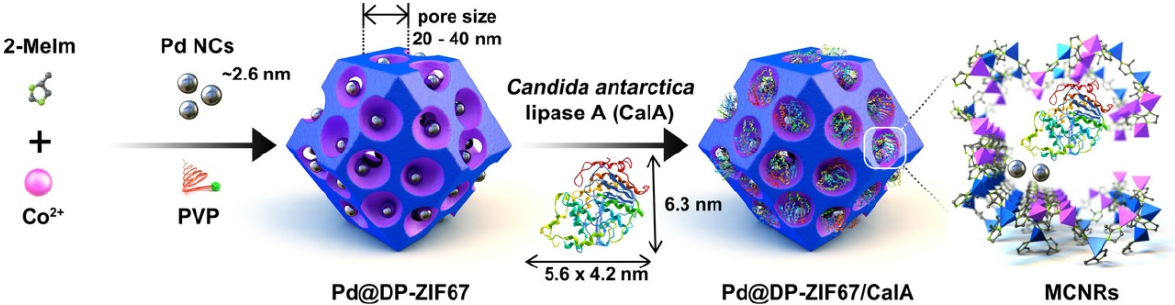
Figure 11. Co-immobilization of Pd and CAL-A into mesopores of ZIF67 [182]. Reprinted from [182] with the permission of John Wiley and Sons.